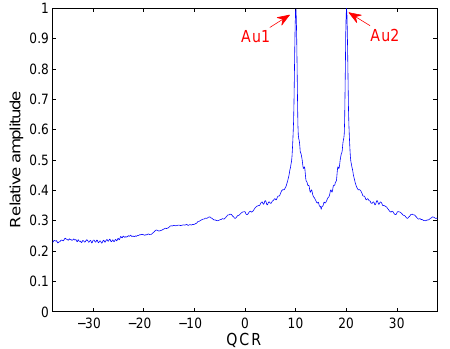
Figure 1. Cross-term suppression of